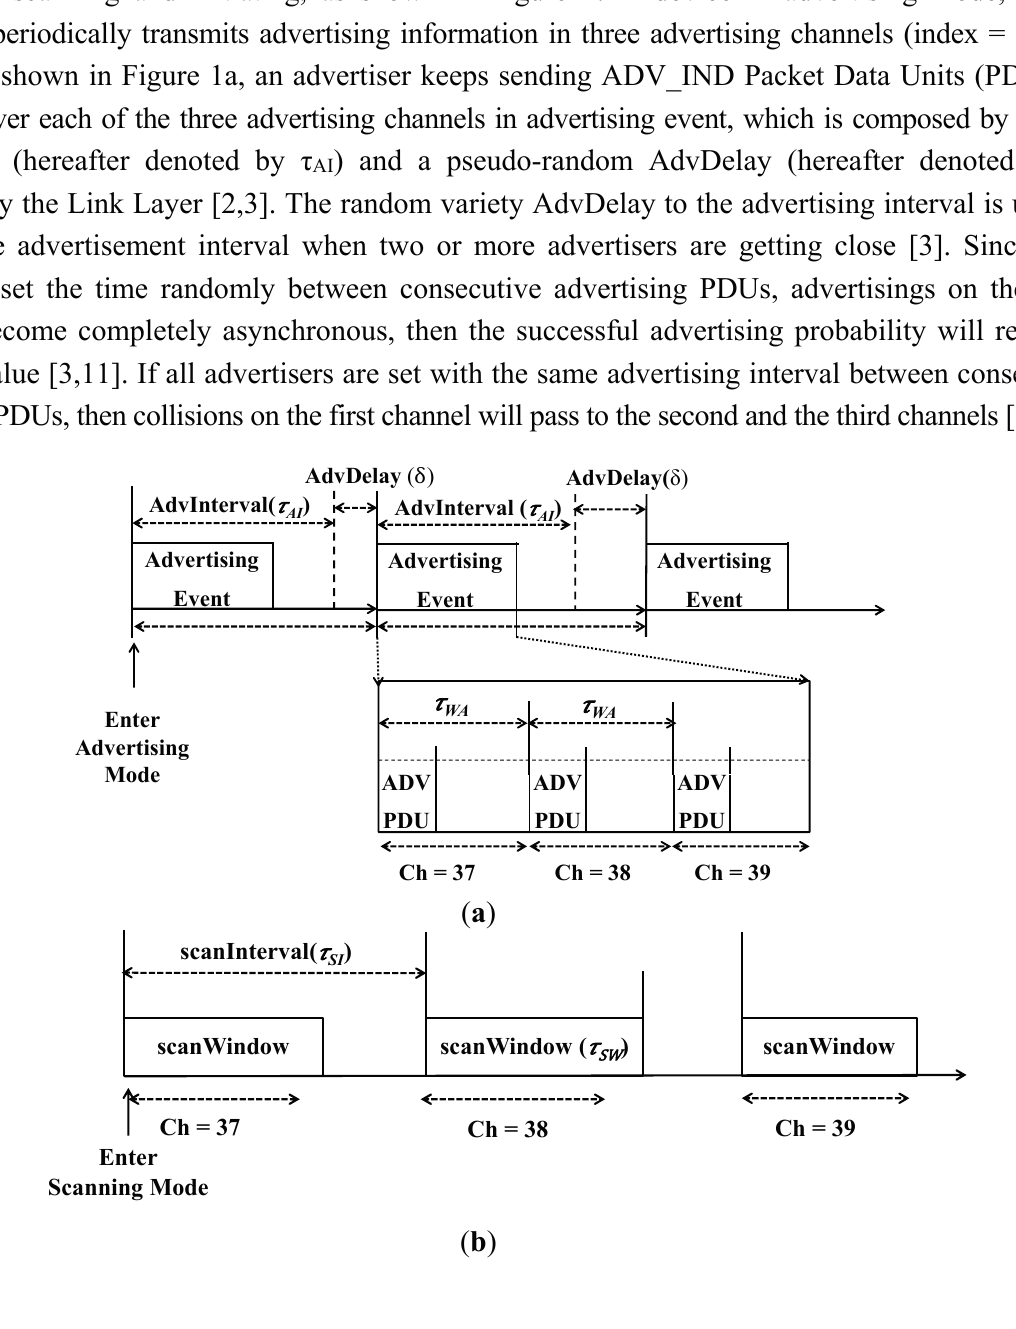
Figure 1. Advertising and scanning process for device discovery [5]. ( a ) Advertising process; ( b ) Scanning